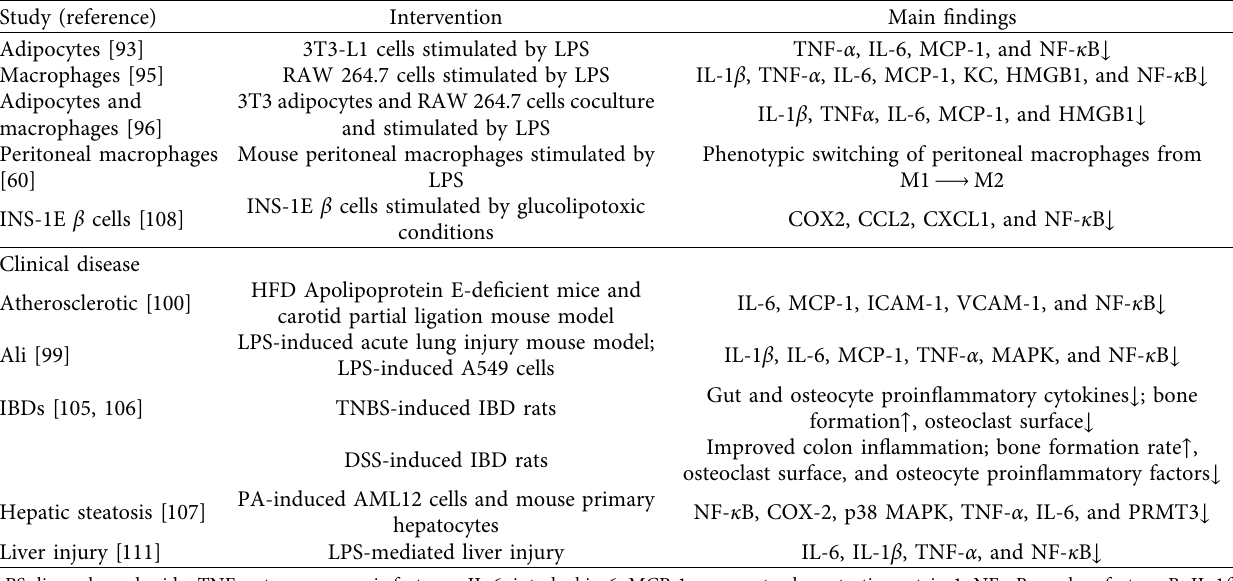
Table 1: Summarizing the anti-inflammatory effects of irisin in various inflammation